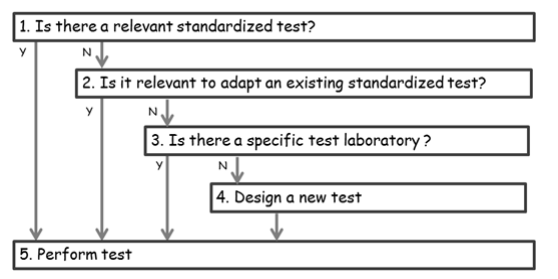
Figure 2. proposed approach for choosing which laboratory tests to carry out Stage 6: assessment method